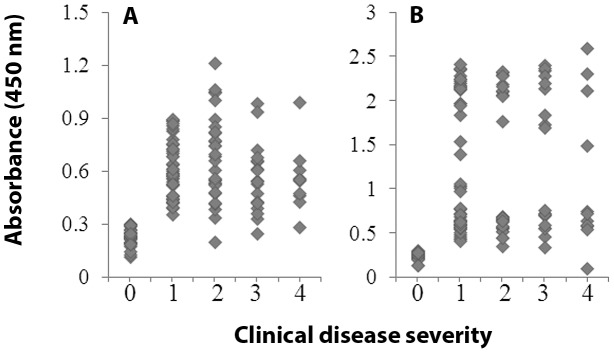
Pair-wise correlation analysis.Shown is pair-wise correlation analysis of antibody response to TcGmix (A) and TcTL (B) with clinical disease category in patients enrolled in the study from Argentina-Bolivia border area. For this, seronegative/healthy subjects were labeled as 0, and patients classified as 0, I, II and III (Materials and Methods) were labeled as 1, 2, 3, and 4, respectively. Dots, individual subjects.